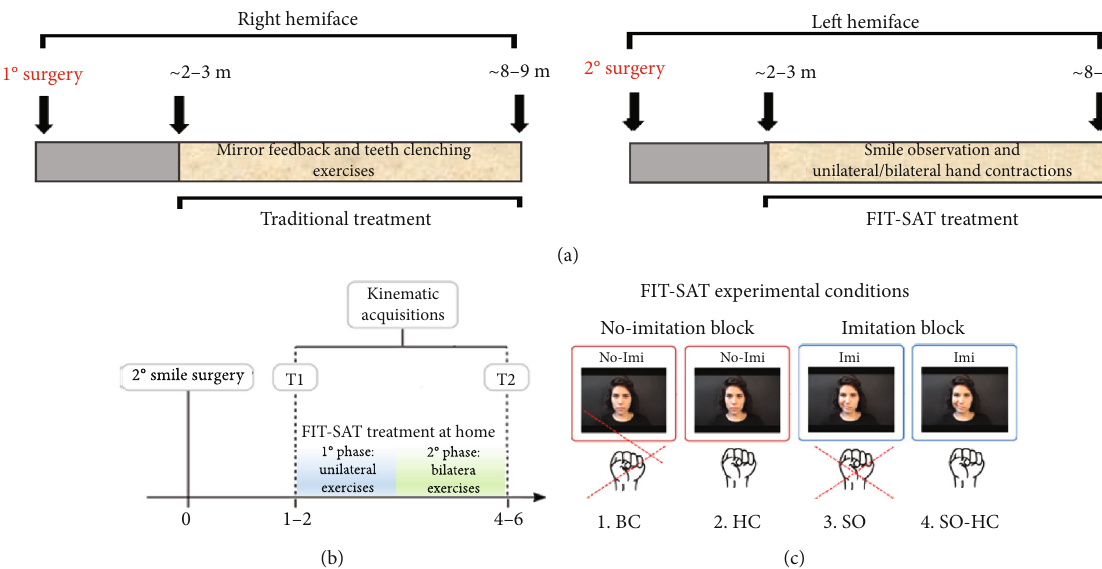
Figure 2: FIT-SAT treatment. (a) The FIT-SAT treatment was performed at home for about 6 months. After the fi rst surgery, the right side of the face was rehabilitated by teeth clenching and mirror feedback. After the second surgery, the FIT-SAT treatment started as soon as the patient began to recruit the muscle. (b) The FIT-SAT treatment was divided into two phases: in the fi rst (unilateral) phase, patients performed unilateral exercises in order to recruit the left transplanted muscle as soon as possible. The second (bilateral) phase started only after the patient was able to perform multiple repetitions of the unilateral left movement maintaining the posture for at least three seconds. From now on, the patient had to learn to coordinate the two sides of the face performing bilateral exercises. (c) Experimental condition: (1) no smile observation and no-hand contraction (baseline condition, BC), (2) no smile observation but hand contraction (HC), (3) smile observation but no-hand contraction (SO), and (4) smile observation and hand contraction